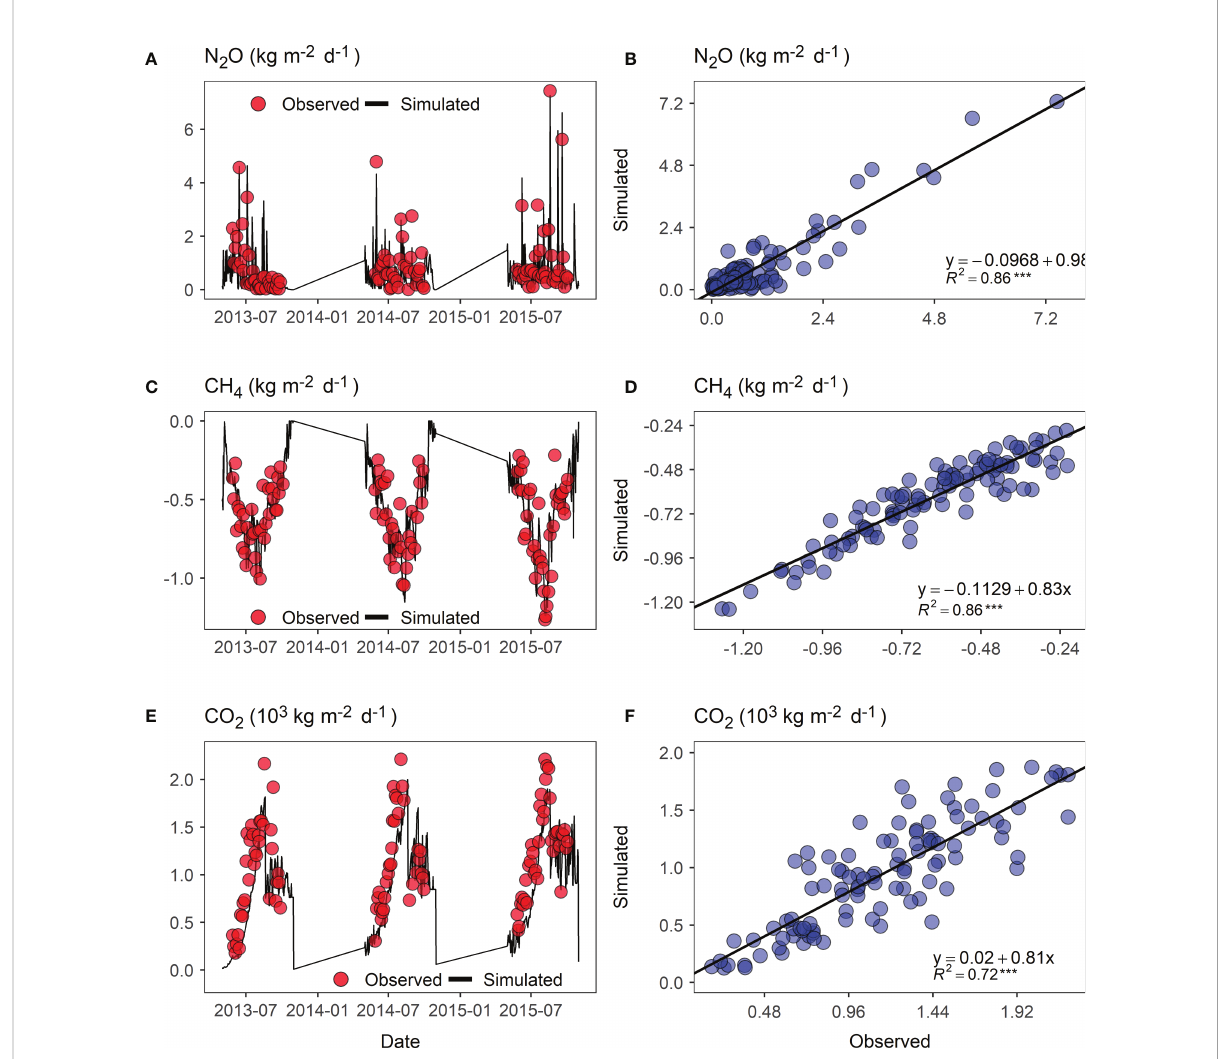
FIGURE 4 Relationship between the simulated versus observed soil greenhouse gas fl uxes of the sown alfalfa pasture fi eld at the Hulunber site. Positive fl ux represents gas emission from the soil, whereas negative fl ux represents gas uptake by the soil. (A, C, E) Field observed N fl uxes (red dots) superposed with DNDC-simulations (black curves); (B, D, F) Scatter plots of observed versus simulated soil N fl uxes. The solid black line represents the linear trend fi tted to the simulated versus the observed data. ***p <